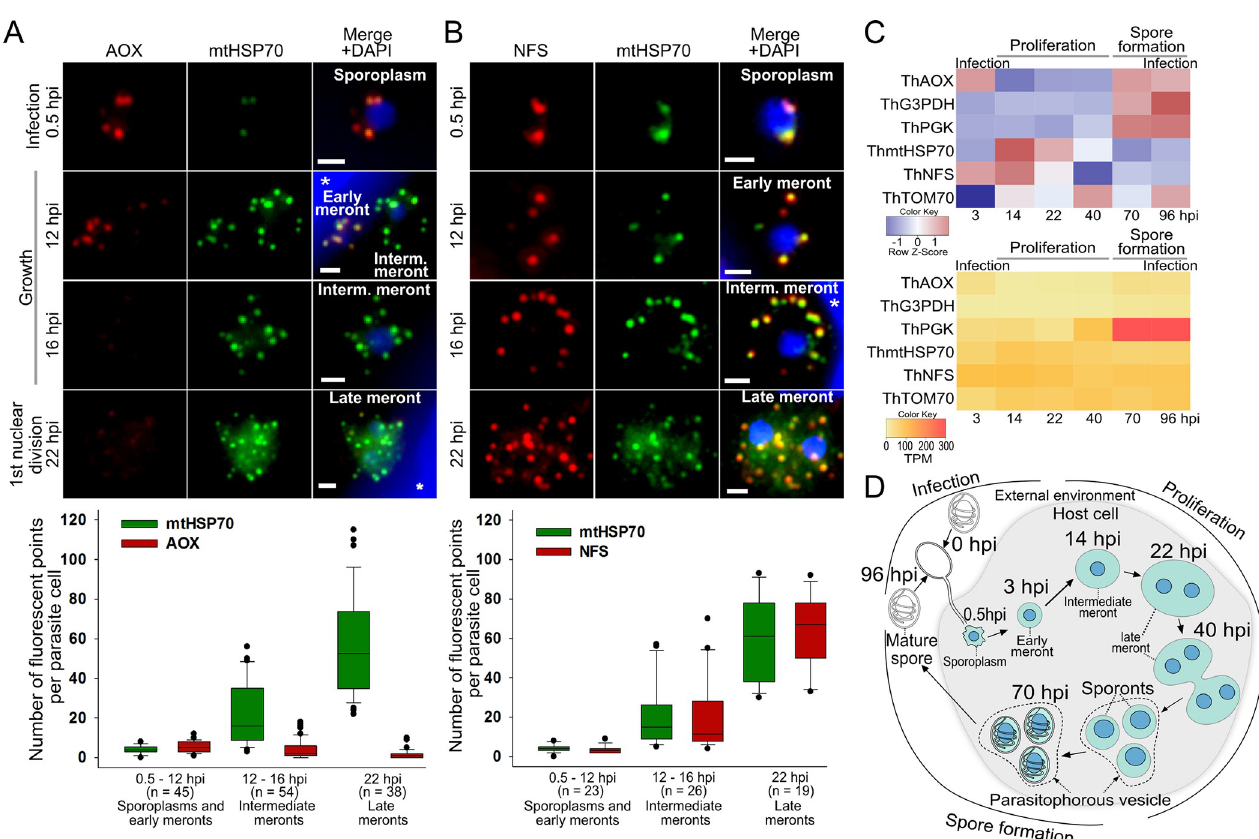
Fig 2. Detection of the AOX and mtG3PDH inside the T . hominis mitosomes at the early meront stages but not the late proliferative stages of the parasite’s infection cycle inside the RK13 host cells. (A) and (B) Representative immunofluorescence images of the T . hominis cells observed at the early time points of the time course of a synchronised T . hominis infection inside the RK13 cells. Methanol-acetone fixed samples were double labelled with the affinity purified antibodies against ThAOX (red, A top panel), or polyclonal sera against ThNFS (red, B top panel); and polyclonal rat sera against ThmtHSP70 (green; A, and B top panel). Presented time points correspond to: the first detection of the intracellular stages of the parasite 30 minutes after addition of the spores (0.5 hpi), increase of the parasite’s cell diameter (12 hpi, 16 hpi), and observation of double nucleate T . hominis cells following the first nuclear division (22 hpi). The observed stages of the parasite life cycle: sporoplasms, and meronts (early, intermediate, and late) were annotated on the images and described in detail in S4 and S5 Figs. The fluorescent images are maximum intensity projections of Z-stack across the parasite cells. Nuclei of the parasite and the host (asterisk) were labelled with DAPI, scale bars correspond to 1 μ m. Analyses of the numbers of the fluorescent point signals detected with the specific antibodies against ThAOX (red, A bottom panel), ThNFS (red, B bottom panel); and ThmtHSP70 (green) inside the T . hominis cells at different stages of the parasite life cycle (A and B top panels, and S4 and S5 Figs). Extended version of the analyses including phase contrast images of the parasite cells, statistical analyses, and results obtained using antibodies against ThG3PDH are presented in S5 Fig. (C) Transcription levels of ThAOX, ThmtG3PDH, ThPGK, ThmtHSP70, ThNFS, and ThTOM70 from RNAseq analyses of samples from a synchronized time course of T . hominis infection sampled at the key intracellular stages of the parasite’s life cycle (D). The transcription levels were presented as TPM (transcripts per million) values (yellow-red scale), or as Z–score values (blue-red scale) to normalize for the differences between relatively highly transcribed PGK and the less abundant transcripts. (D) The model is based on previously published data [5] and presents the key stages of the life cycle of T . hominis : 0 hpi—the extracellular environmental spore (Mature spore) injects its contents (Sporoplasm) into the host cell using a specialised infection apparatus called a polar tube, 3 hpi–observation of small ovoid early meront cells, 14 hpi–increase in the parasite’s cell diameter and observed decreased number of the mitosomes labelled with anti-AOX/mtG3PDH antibodies, 22 h–first division of the parasite’s nuclei, 40 h–first division of the parasite’s cells, 70 h–initiation of the spore formation, 96 h–mature spores infect new uninfected host cells. During the Proliferation stage, the parasite is capable of stealing ATP from its host via nucleotide NTT transporters (inset figure). Dashed line indicates the membrane vesicle (parasitophorous vesicle) that surrounds parasite cells residing inside the host